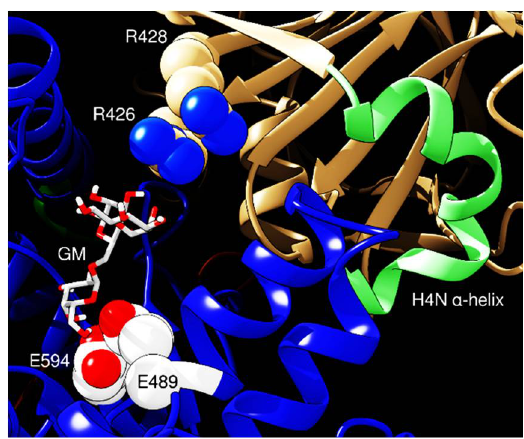
Figure 7. Docking of γC (tan color) and ThMan2A (catalytic domain: blue) as predicted by HDOCK software. The picture is a selected area showing the region of the active site; ThMan2A domain 1 is omitted for better representation. The banana-shaped α-helix of γC is colored in light green. Red and white balls are the catalytic residues, whereas β-galactomannan (GM) is reported as sticks.